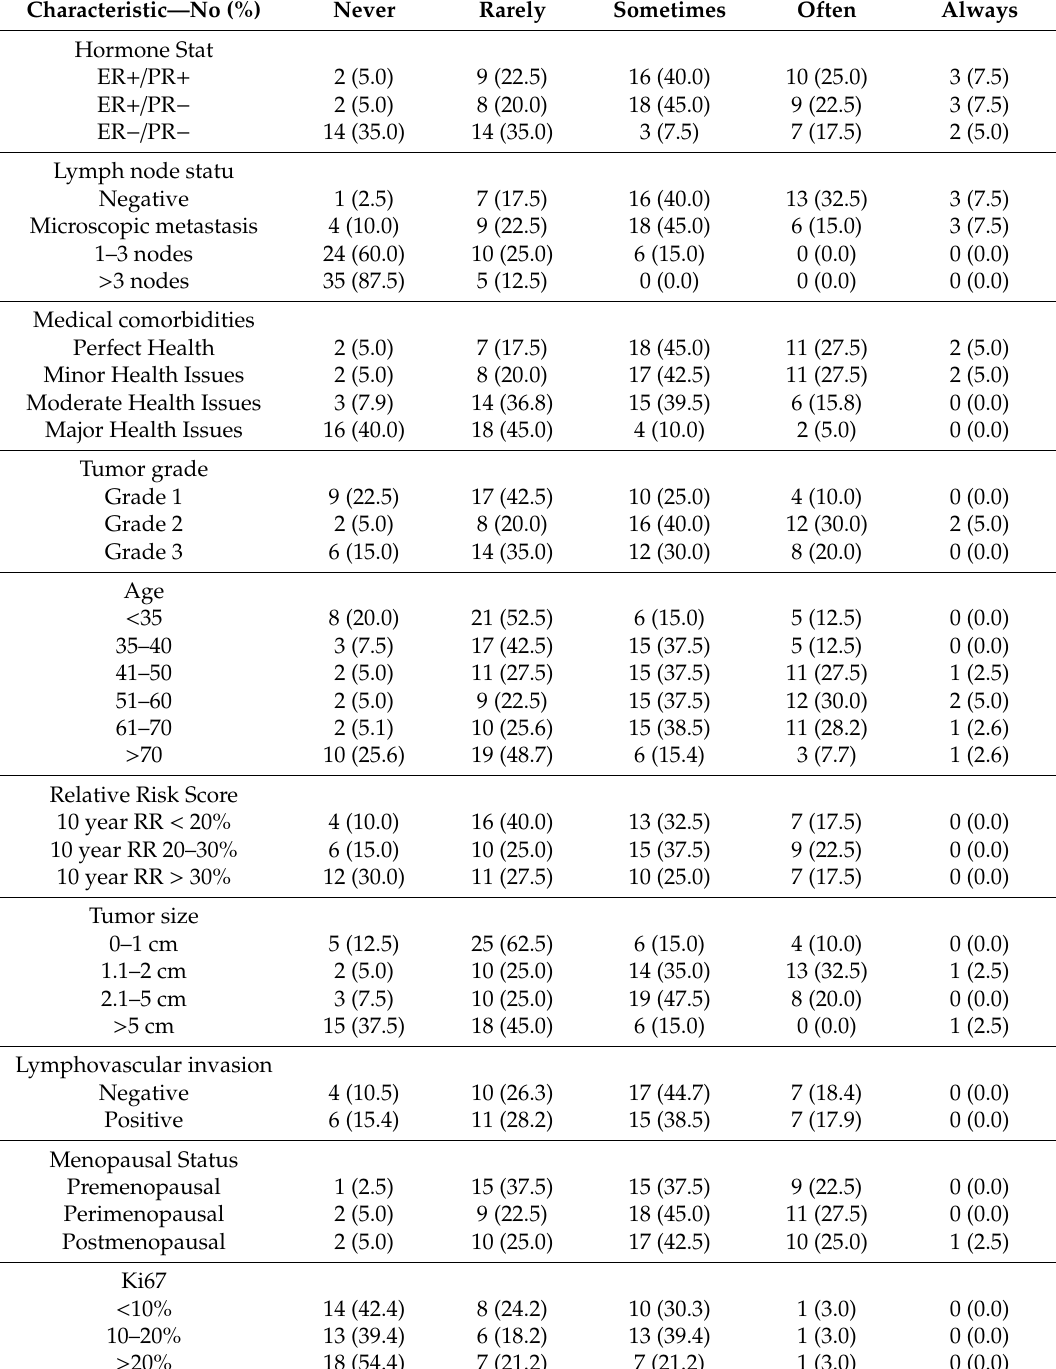
Table 3. Survey question: How frequently do you use Oncotype DX for the following clinical and pathologic features? (Never, Rarely, Sometimes, Often,